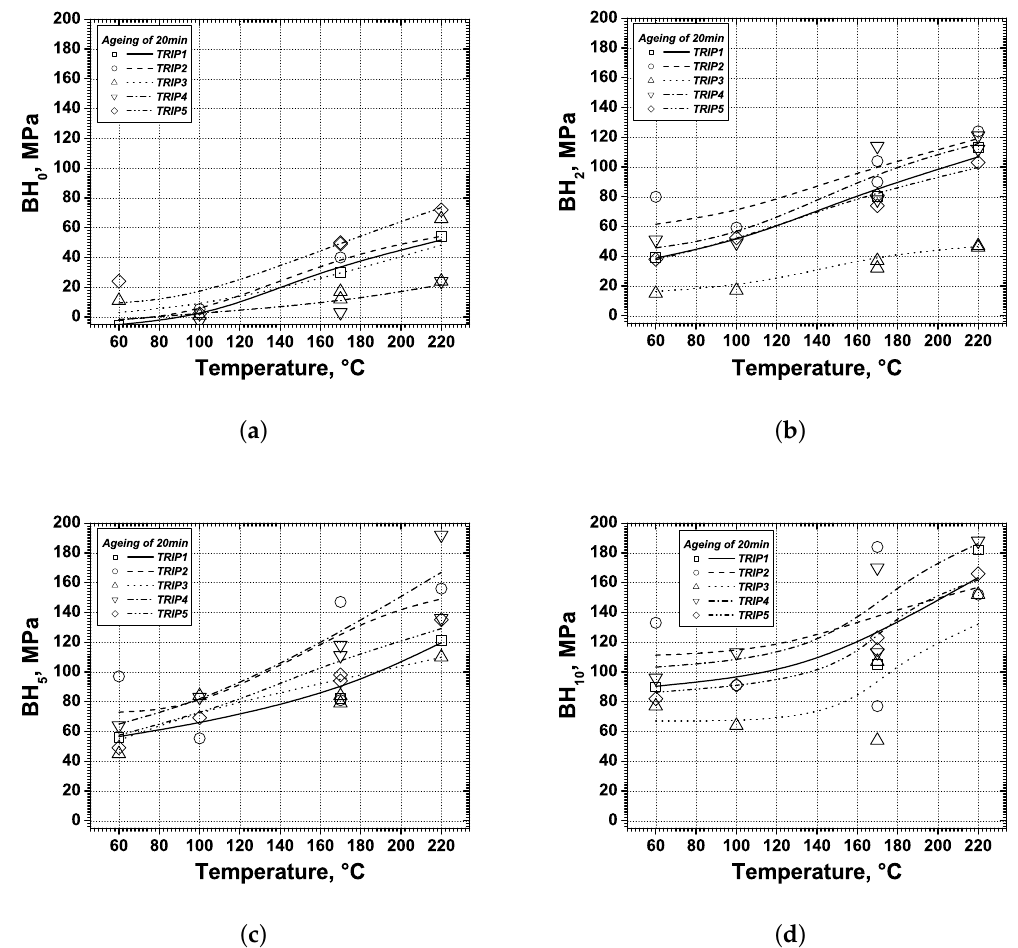
Figure 2. Bake-hardening values versus temperature for the investigated TRIP1–TRIP5 steels for 20 min of aging with different prestrain values for BH x ( a ) BH 0 (with no prestrain), ( b ) BH 2 (2 % prestrain), ( c ) BH 5 (5 % prestrain), ( d ) BH 10 (10 %